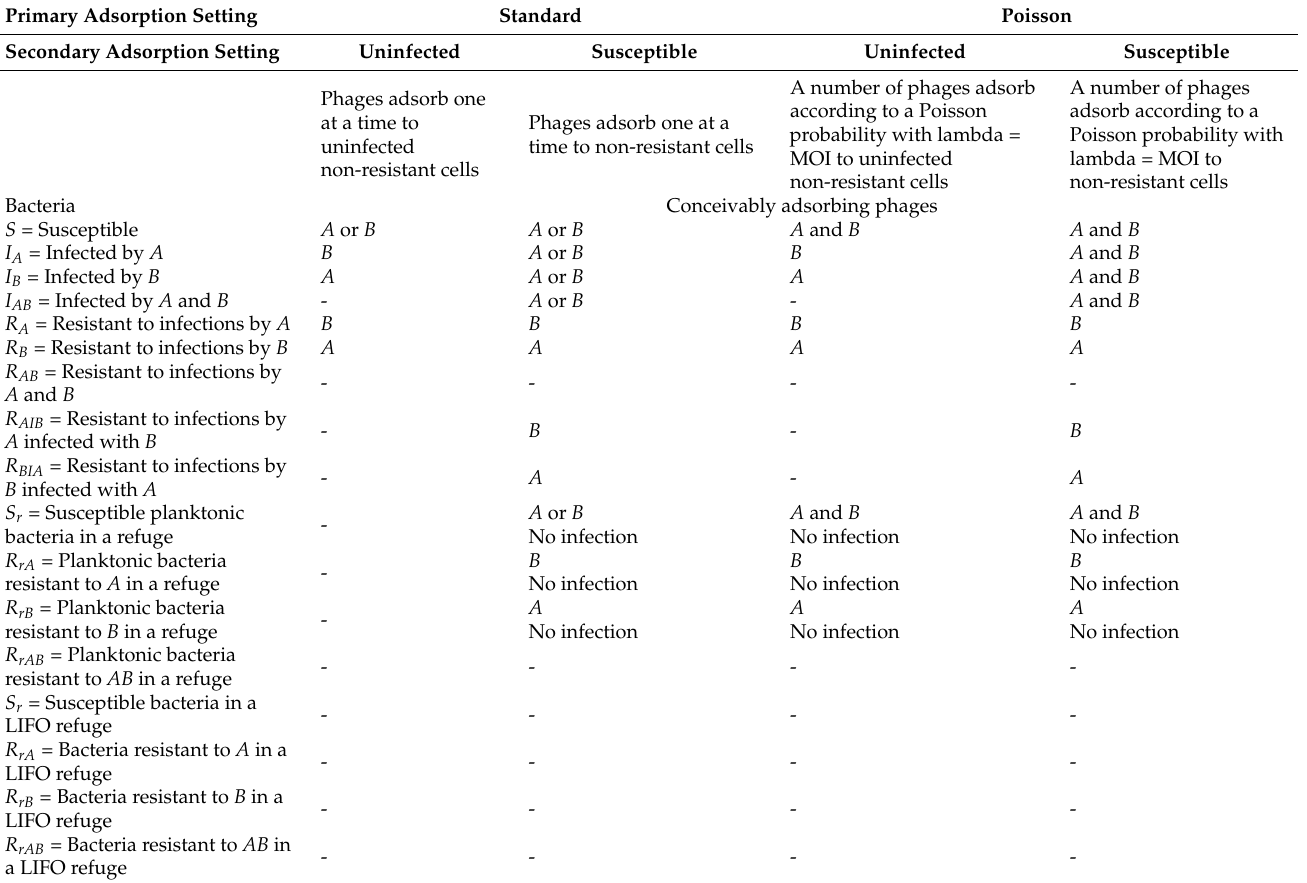
Table 2. Adsorbed A and B phages per unit time under the primary and secondary adsorption